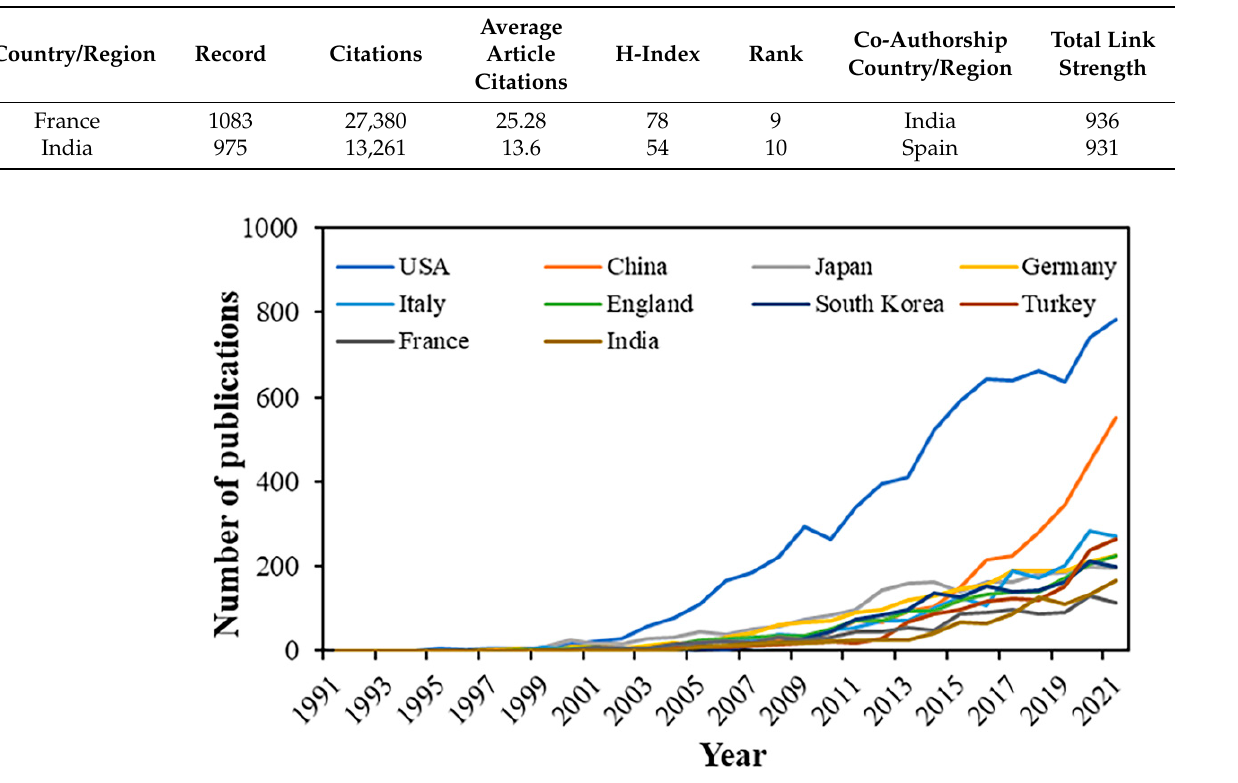
Figure 5. Number of publications of the top 10 productive countries/regions.